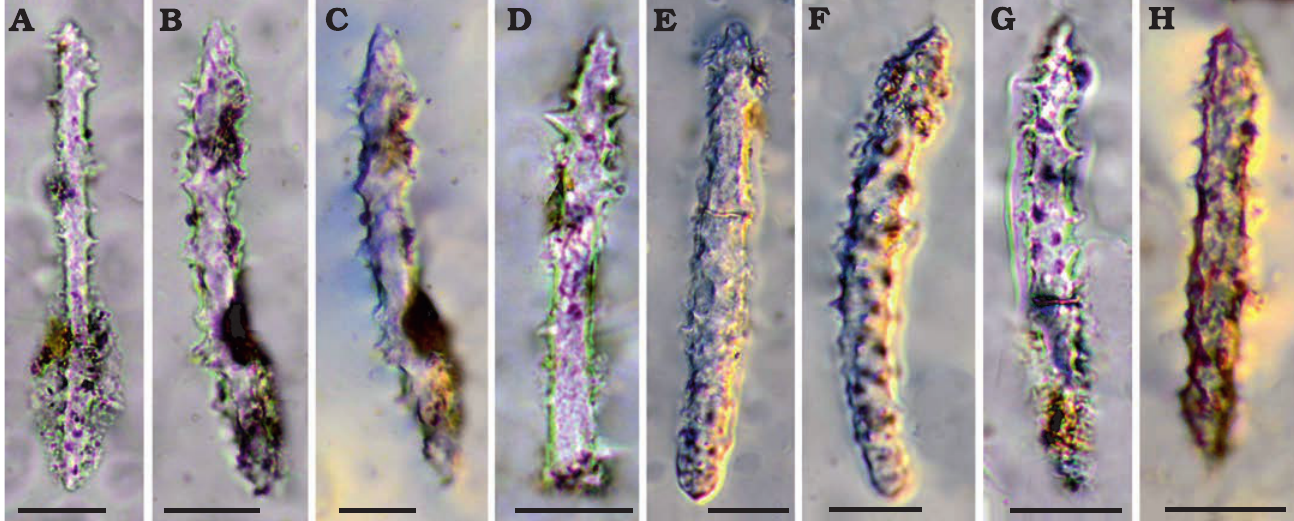
Fig. 2. Megascleres of palaeospongillid sponge Longibirotula antiqua gen. et sp. nov. from Upper Cretaceous–lower Paleocene of Naskal GSI Quarry (India). {fig. will be greyscale in printed